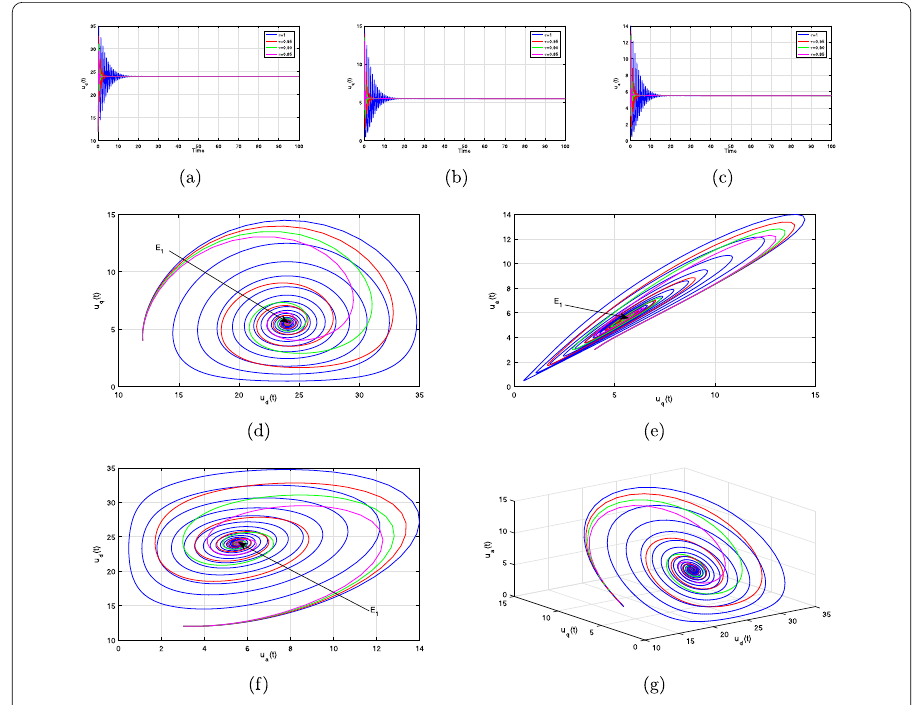
Figure 8 Simulations of Example 7 for time-fractional brushless DC motor (11) in the AB–Caputo